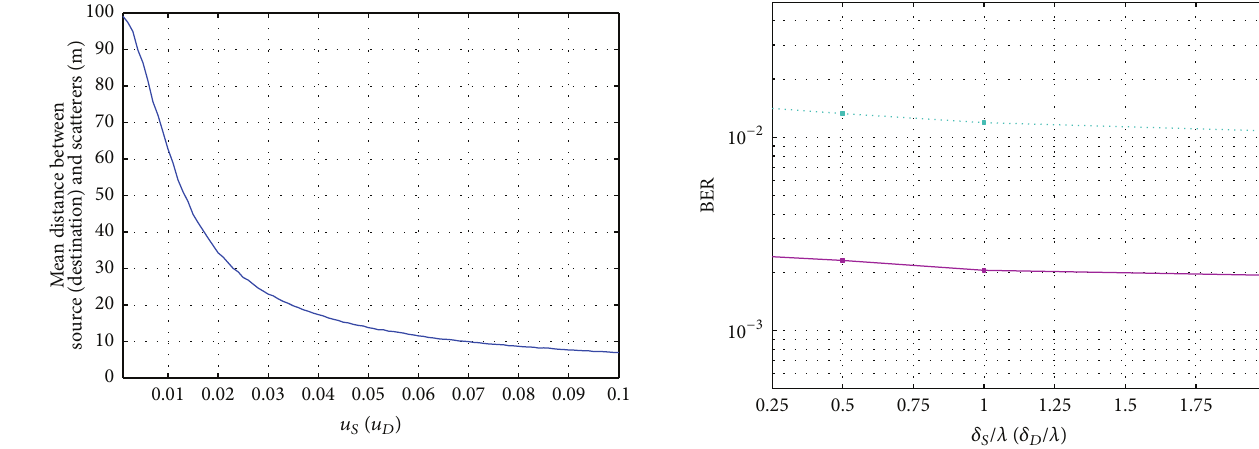
Figure 4: The mean distance between the source (destination) and the scatterers within cylinder 1 (2) for different values of the parameter 𝑢 𝑆 ( 𝑢 𝐷 ).